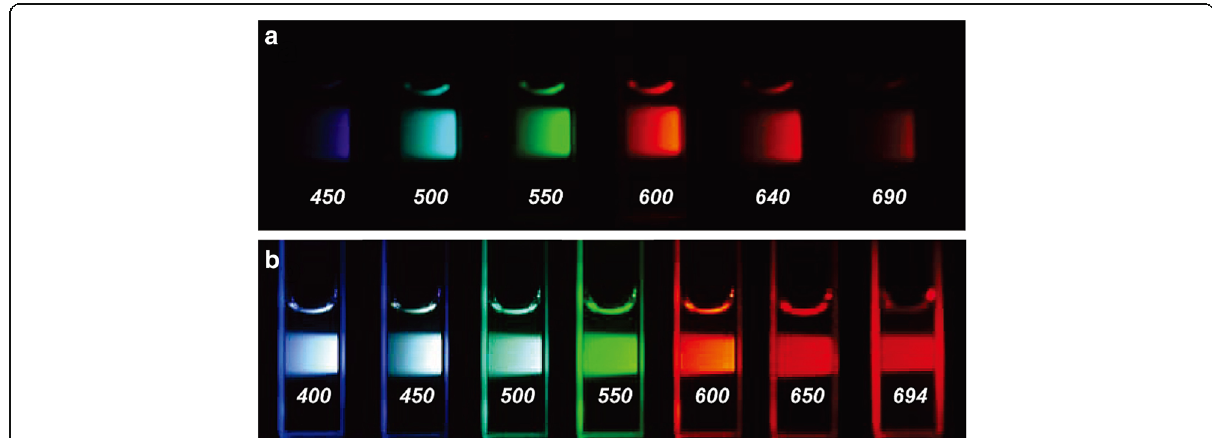
Fig. 1 Aqueous solution of diaminopolyethylene glycol (PEG1500N)-attached CDs ( a ) excited at 400 nm and photographed through band-pass filters of different wavelengths (as indicated) and the CDs ( b ) excited at the indicated wavelengths and photographed directly